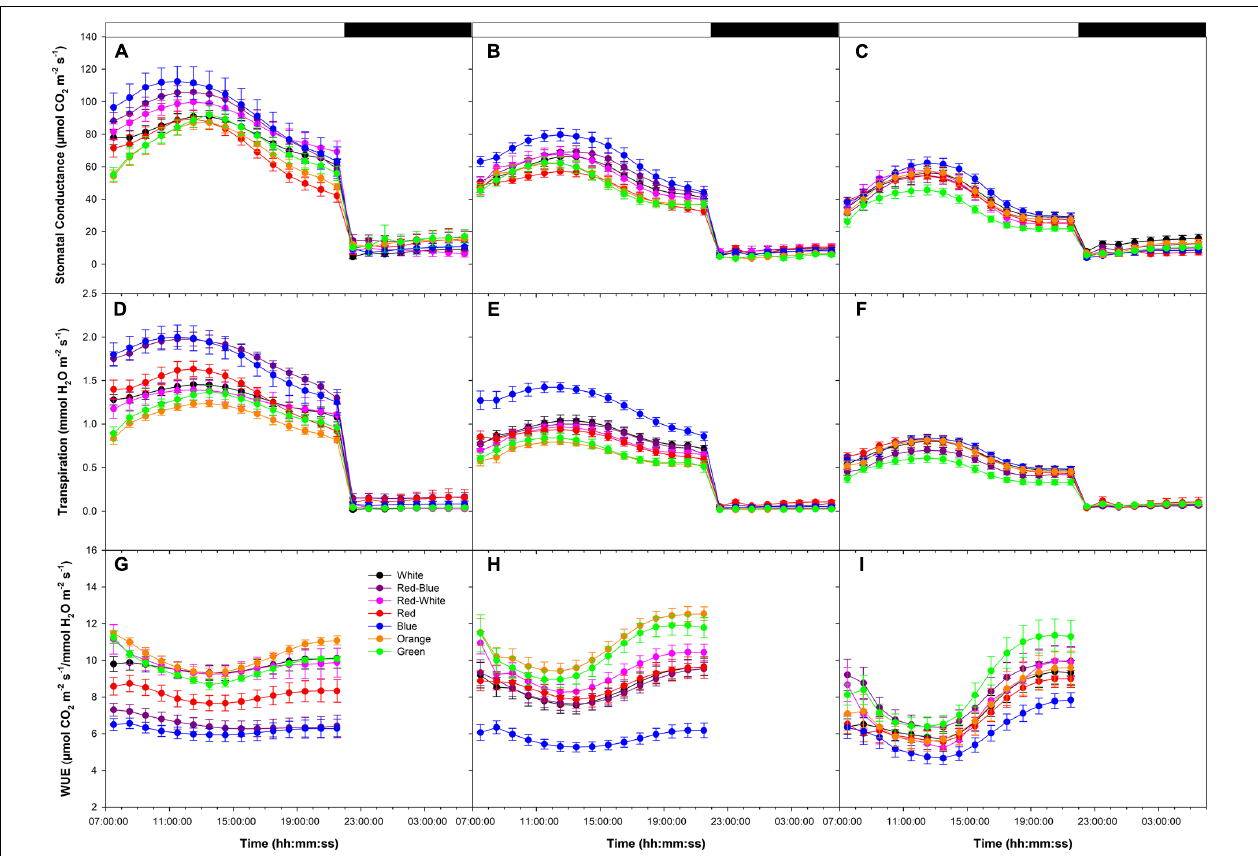
FIGURE 7 | Diurnal patterns of stomatal conductance (A–C) , transpiration rate (D–F) , and WUE (G–I) of leaves during the light period under various wavelength specific LEDs. A,D,G show these values from export experiments done at an initial high photosynthetic level of ∼ 12 µ mol m − 2 s − 1 . Panels B,E,H show these values from export experiments done at an initial medium photosynthetic level of ∼ 8 µ mol m − 2 s − 1 . C,F,I show these values from export experiments done at an initial low photosynthetic level of ∼ 4 µ mol m − 2 s − 1 .